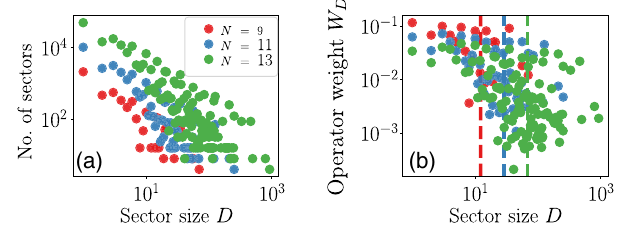
FIG. 3. Sector size and weight distributions. (a) Distribution of invariant subspaces of size D and (b) operator weight W D (see the text for its definition) of the operator S z 0 in each invariant subspace H D in the full Hilbert space. The vertical dashed i of dimension lines indicate the averaged sector size of the distribution, which is exponentially smaller than the largest